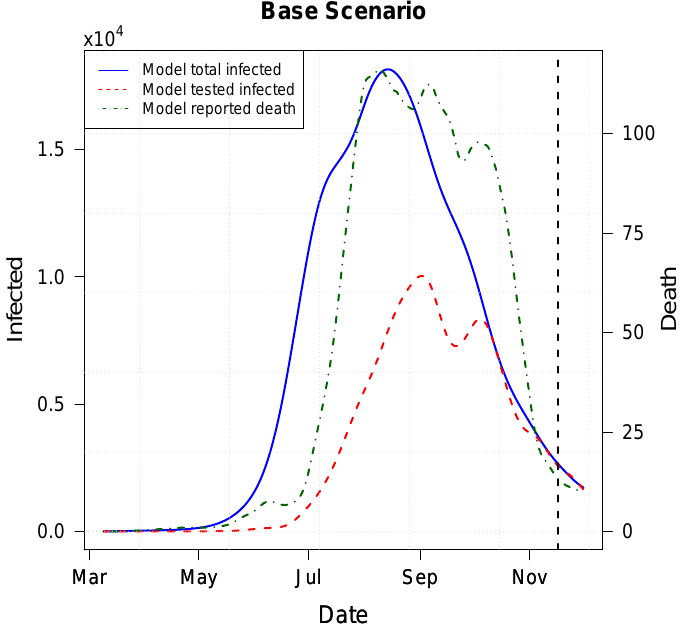
Figure 7. Fitted posterior predictive mean for